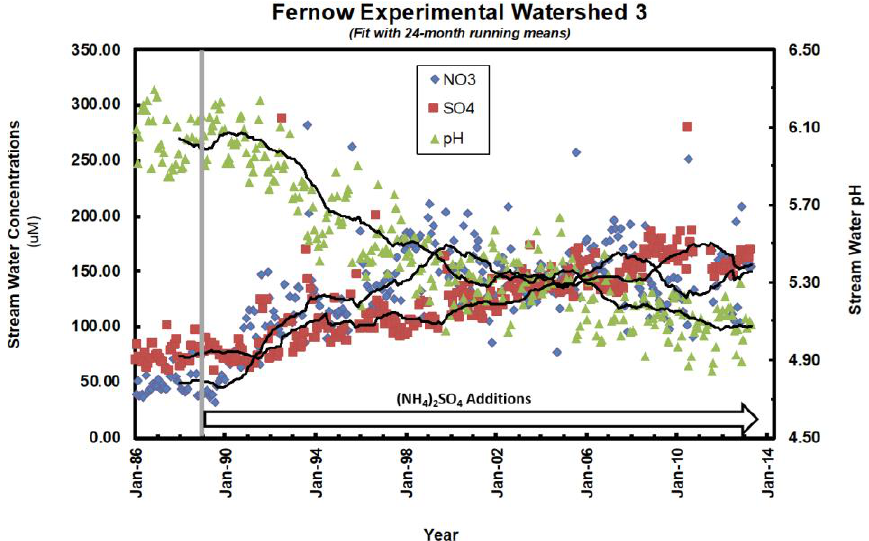
Figure 6. Monthly mean stream water pH and concentrations of NO 3 − and SO 4= for treated WS3 from 1986 to 2014.